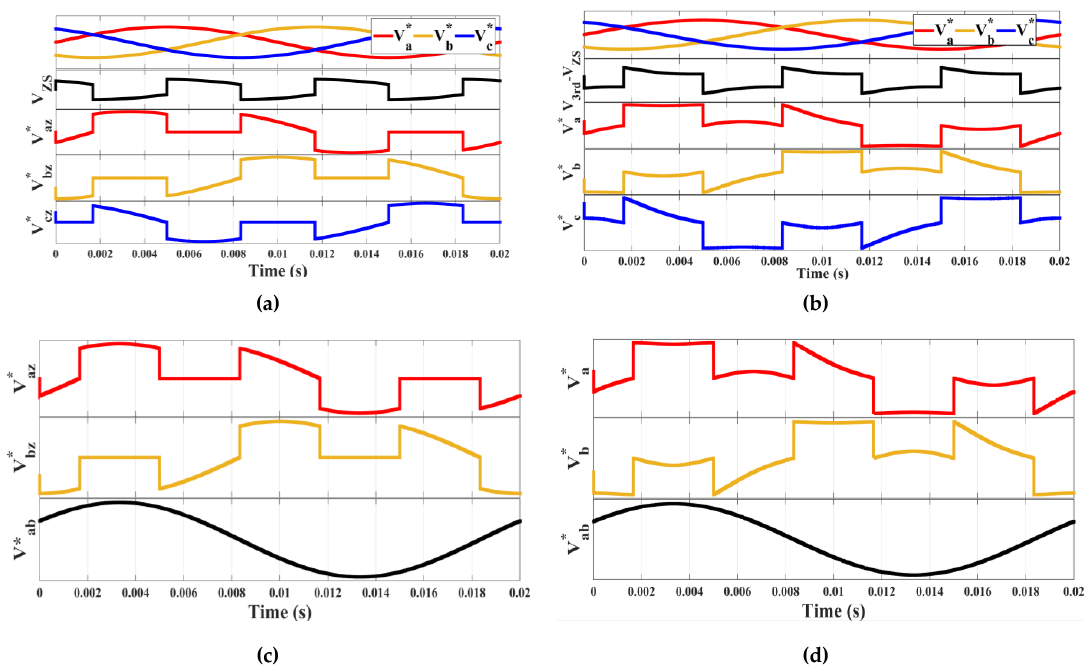
Figure 4. ZSI-DCPWM references: ( a ) Conventional ZSI-DCPWM references generation, ( b ) Proposed Modified DCPWM references generation, ( c ) Conventional ZSI-DCPWM line voltage, and ( d ) Proposed Modified DCPWM line